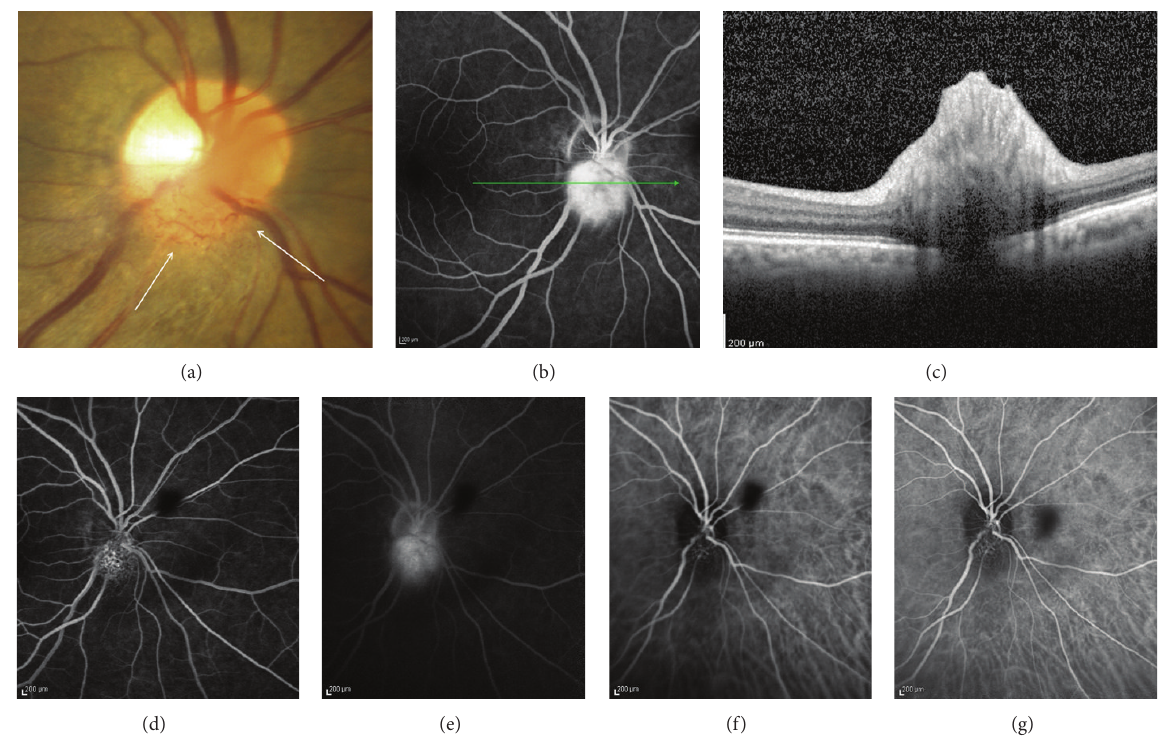
Figure 1: (a) Through. (c) Fundus photo, fluorescein angiography late phase, and optical coherence tomography at presentation. (d)-(e) Fluorescein angiography early and late phase at presentation. (f)-(g) Indocyanine green angiography early and late phase at presentation.